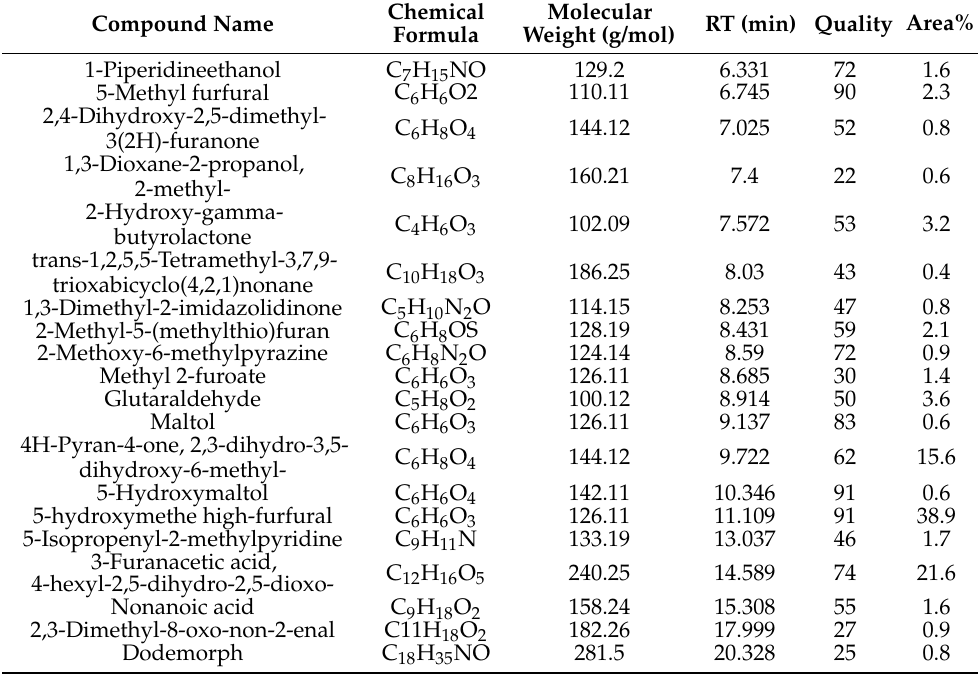
Table 4. The GC-MS analysis of the crude methanol extract obtained from mycelia-free medium that used to cultivation of ascospores of T . nivea